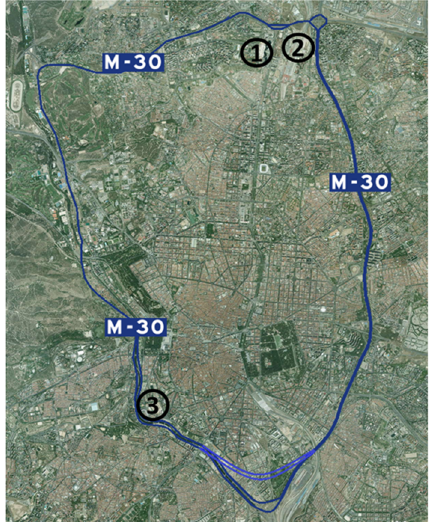
Figure 1. Recent large-scale projects in Madrid city centre 1. Cuatro Torres; 2. Madrid Nuevo Norte; and 3. Nuevo Mahou-Calderón (source: the author).